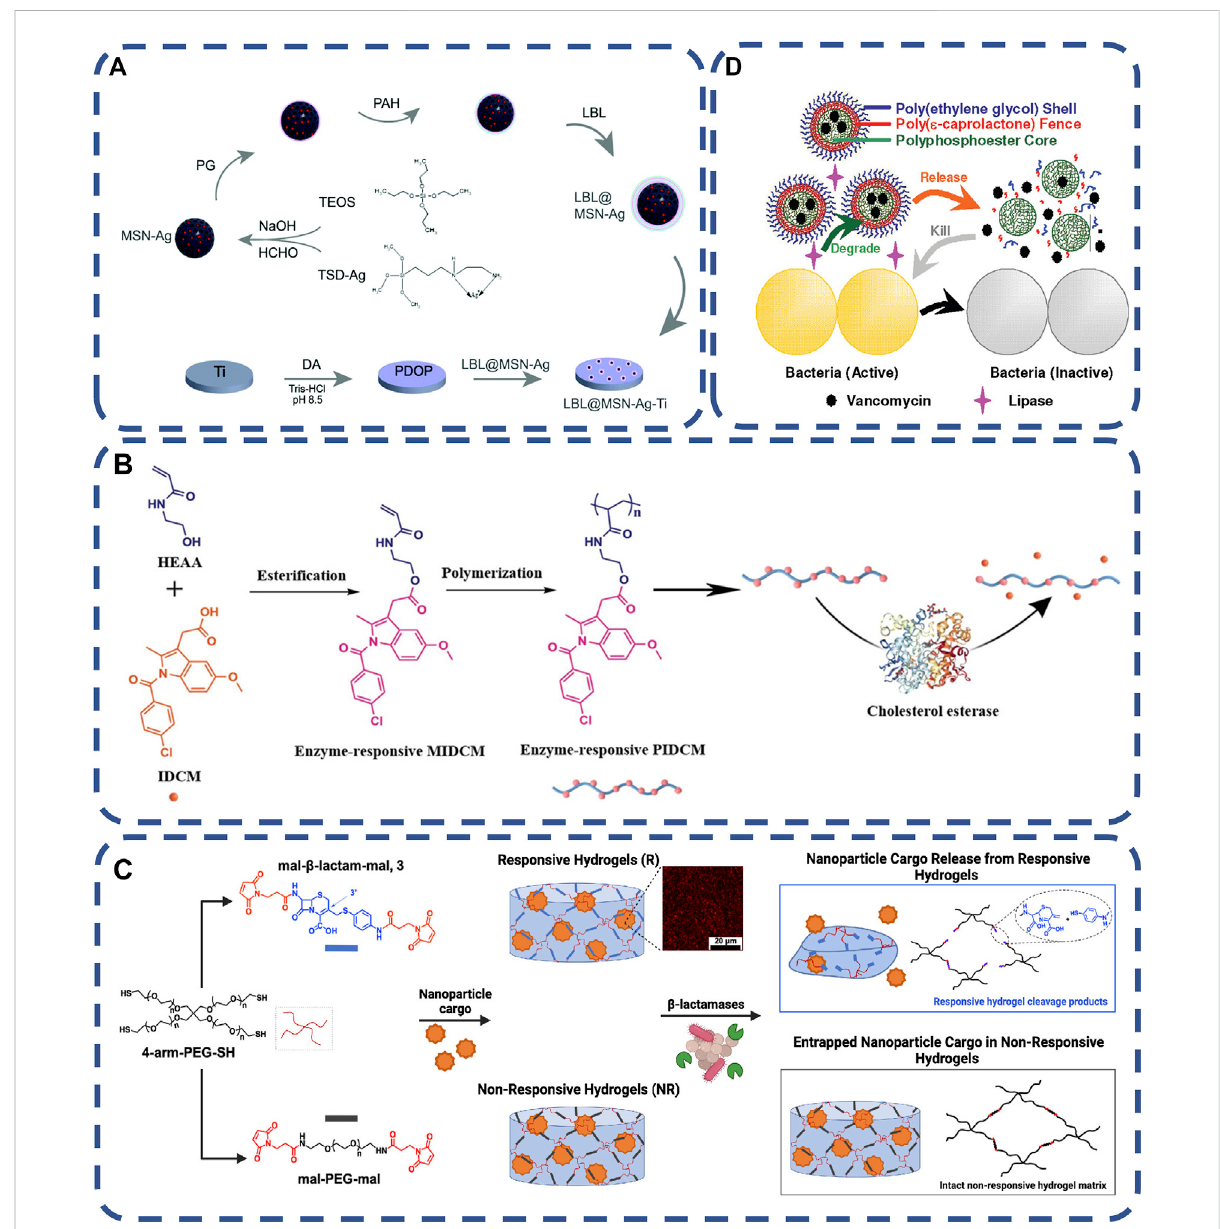
FIGURE 1 (A) schematic diagram of preparation process of LBL@MSN-Ag modi fi ed Ti substrate (Ding et al., 2020). Copyright 2020, Biomater Sci. (B) Schematic diagram of on-demand drug delivery triggered by bacterial lipase in the treatment of bacterial infection using polymerized